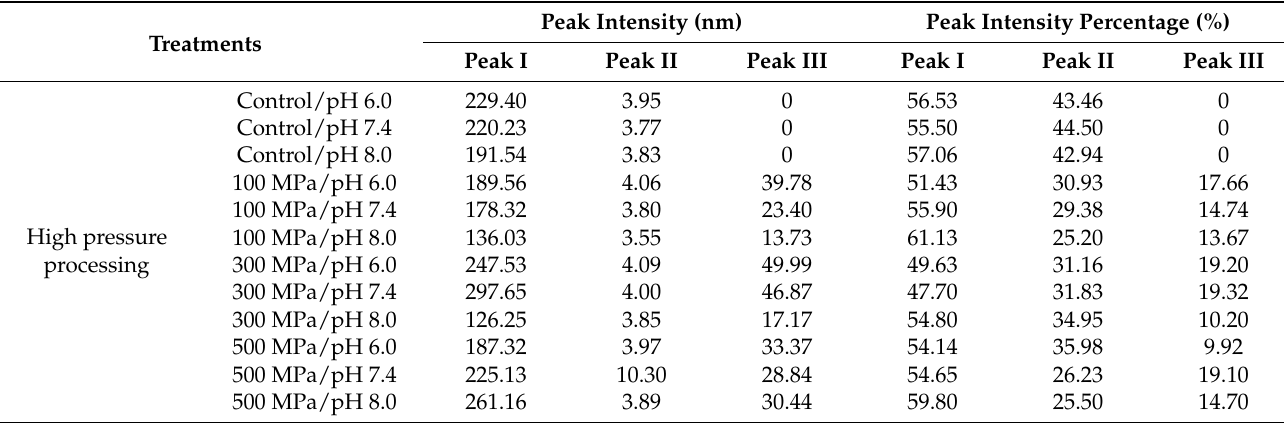
Table 3. The particle size distribution of α -lactalbumin under different